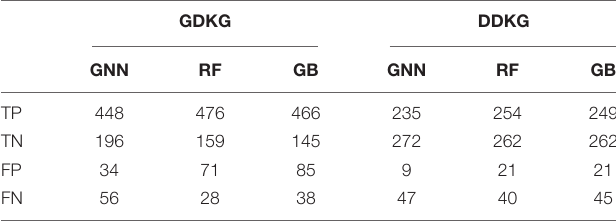
TABLE 8 | Results using Graph Neural Network (GNN), Gradient Boosting (GB), and Random Forest (RF) for link prediction in the Gene Disease Knowledge Graph (GDKG) and Disease Drug Knowledge Graph